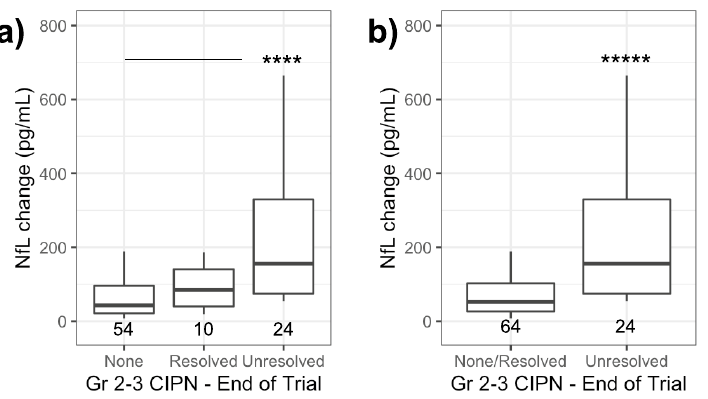
Figure 6. NfL change predicts unresolved grade 2 and 3 CIPN. ( a ) NfL change for CIPN by grade and status at the end of the trial. ( b ) NfL change in unresolved grade 2–3 CIPN compared to all other subjects. **** p < 0.0001; ***** p < 0.00001 by Dunn’s test panel ( a ) or Wilcoxon rank sum test panel ( b